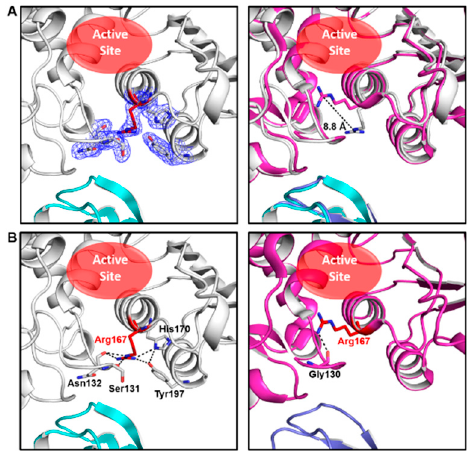
Figure 1. Our ATCase structure and its comparison with a previously solved ATCase structure adopting common conformation of Arg167. ( A ) Our structure of wild-type E. coli ATCase holoenzyme (left) and its alignment with an ATCase structure (PDB ID 1ZA1) with a closed conformation of Arg167 (right). In the left figure, the open conformation of Arg167 and its interacting residues are shown as sticks in electron density map (contoured at 1.0 σ ), and Arg167 is colored in red, catalytic subunit in white, regulatory subunit in cyan. The active site is indicated by a red ellipse. In the right figure, the distance between different conformations of Arg167 is indicated and the position of the active site is also shown. ( B ) The interactions of open (left) and closed (right) conformation of Arg167. Arg167 and its interacting residues are labeled and shown as sticks and Arg167 is colored in red. Table 1. X-ray diffraction data and refinement statistics of E. coli ATCase holoenzyme a .